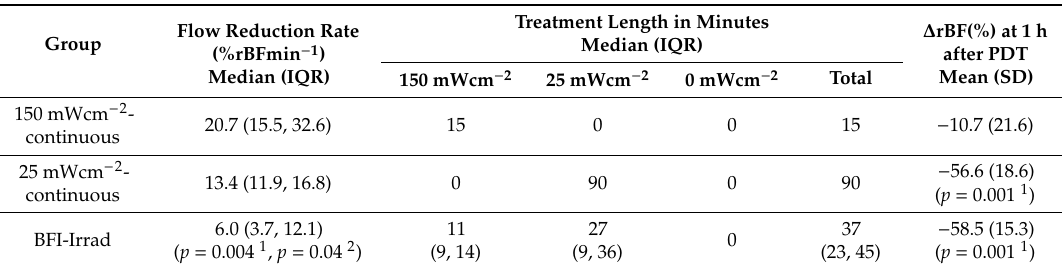
Table2. ForAB12tumors, flowreductionrate(overallflowreductionrateforBFI-Irrad), treatmentlength (segregated by time spent at each irradiance), and ∆ rBF at 1 h after PDT with 150 mWcm − 2 -continuous, 25 mWcm − 2 -continuous or